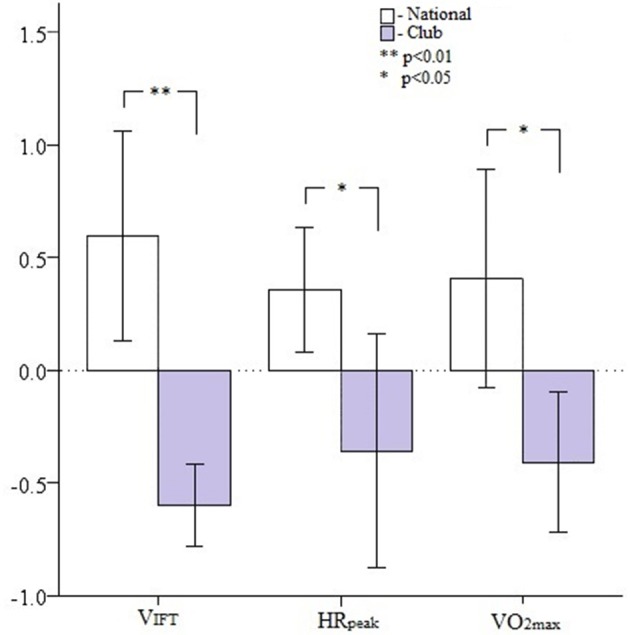
Differences between national selection and national league level players for the 30–15IFT test–retest end speed (VIFT), maximal heart rate (HRpeak) and maximal oxygen consumption (VO2max) expressed as standardized units (Z-values).